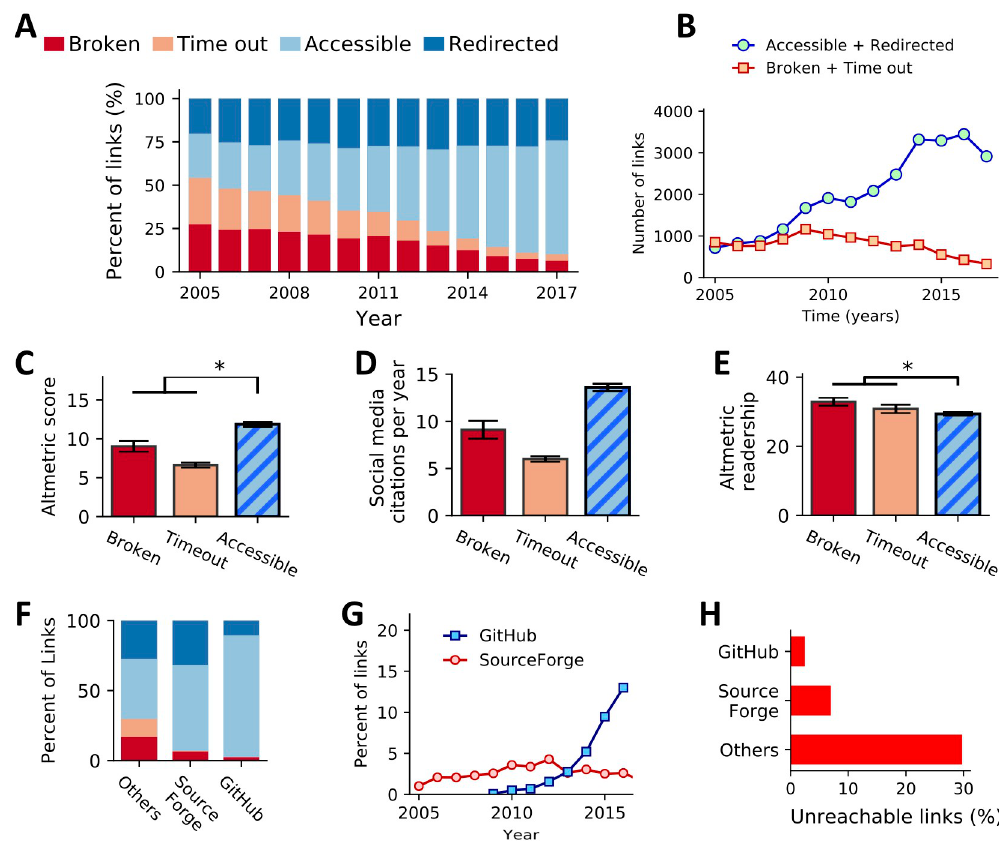
Fig 1. Archival stability of 36,702 published URLs across 10 systems and computational biology journals over the span of 13 years. An asterisk ( � ) denotes categories that have a difference that is statistically significant. Error bars, where present, indicate SEM. (A) Archival stability status of all links evaluated from papers published between 2005 and 2017. Percentages of each category (y-axis) are reported over a 13-year span (x-axis). (B) A line graph comparing the overall numbers (y-axis) of functional (green circles) and nonfunctional (orange squares) links observed in papers published over time (x-axis). (C) A bar chart showing the mean Altmetric “attention score” (y-axis) for papers, separated by the status of the URL (x-axis) observed in that paper. (D) A bar chart showing the mean number of mentions of papers in social media (blog posts, Twitter feeds, etc.) according to Altmetric, divided by the age of the paper in years (y-axis). Papers are separated by the status of the URL (x-axis) found in the paper. (E) A bar chart illustrating the mean Altmetric readership count per year of papers (y-axis) containing URLs in each of the categories (x-axis). (F) The proportion of unreachable links (due to connection time-out or due to error) stored on web services designed to host source code (e.g., GitHub and SourceForge) and “Other” web services. (G) A line plot illustrating the proportion (y-axis) of the total links observed in each year (x-axis) that point to GitHub or SourceForge. (H) A bar chart illustrating the proportion of links hosted on GitHub or SourceForge (vertical axis) that are no longer functional (horizontal axis) compared with links hosted elsewhere. SEM, standard error of the mean; URL, uniform resource